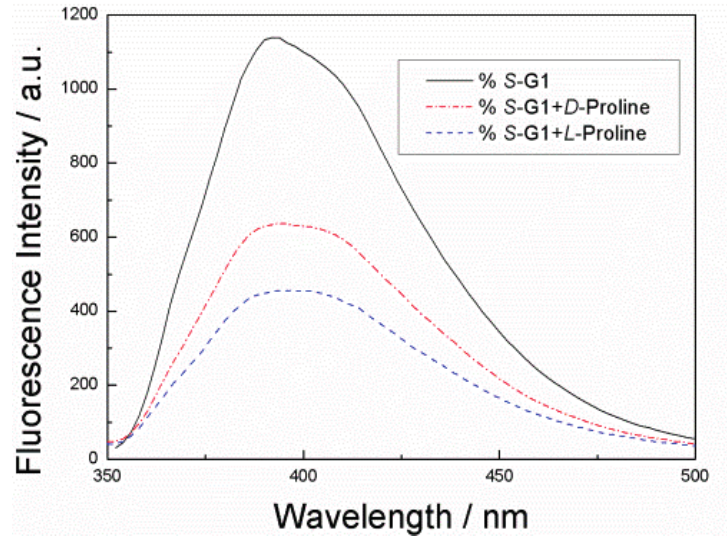
Figure 4. Fluorescence spectra of S -G1 (8 × 10 − 5 mol·L − 1 ) in EtOH solution, S -G1 (8 × 10 − 5 mol·L − 1 ) with D -priline (1.2 × 10 − 2 mol·L − 1 ) and S -G1 (8 × 10 − 5 mol·L − 1 ) with